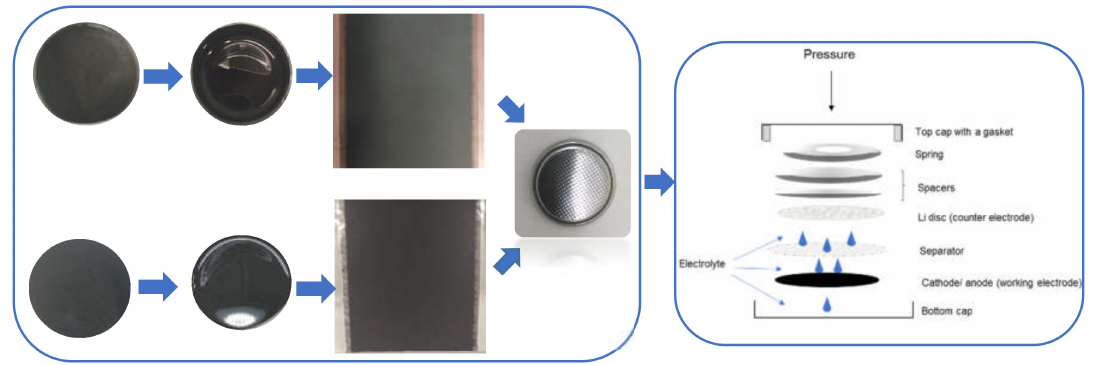
Figure 12. Anode and cathode coating preparation from the reclaimed material, top diagram presents anode, bottom cathode process steps: reclaimed active material, mixed slurry, electrode coating and coin